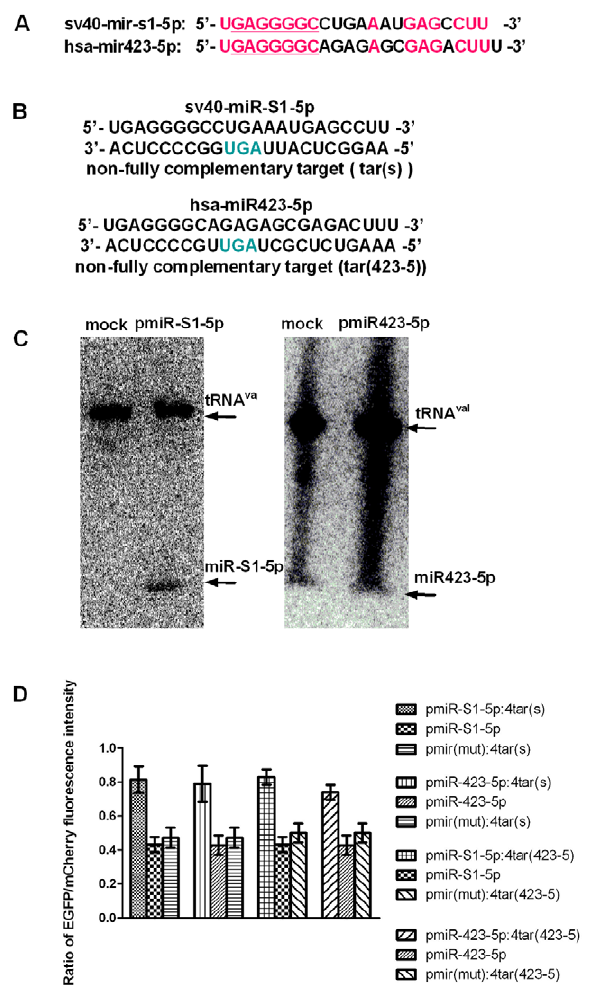
Figure 4. sv40-miR-S1-5p and hsa-miR423-5p share a seed sequence and target common artificial mRNA sequences. (A) Sequence homology between sv40-miR-S1-5p and hsa-miR423-5p (marked in red). The seed regions of miRNAs were underlined. (B) Sequences of sv40-miR-S1-5p, miR423-5p and their non-fully comple- mentary targets. (C) Northern blot analysis of the transcription of miR- S1-5p and miR423-5p. HeLa cells were mock-transfected (mock) or transfected with plasmids pmiR-S1-5p and pmiR423-5p individually. The location of the mature miR-S1-5p and miR423-5p is indicated. tRNA Val served as a loading control. (D) Fluorescence reporter assay of the indicator vectors pmiR-S1-5p:4tar(s), pmiR423-5p:4tar(s), pmiR-S1- 5p:4tar(423-5), pmiR423-5p:4tar(423-5) and their control vectors with miRNAs or target sequences only. doi:10.1371/journal.pone.0036157.g004 activity. In the vector pMGhU6 (see Figure 1), miRNAs are produced under the control of the human U6 promoter, and EGFP and mCherry are independently expressed under the control of two divergent CMV immediate-early promoters.